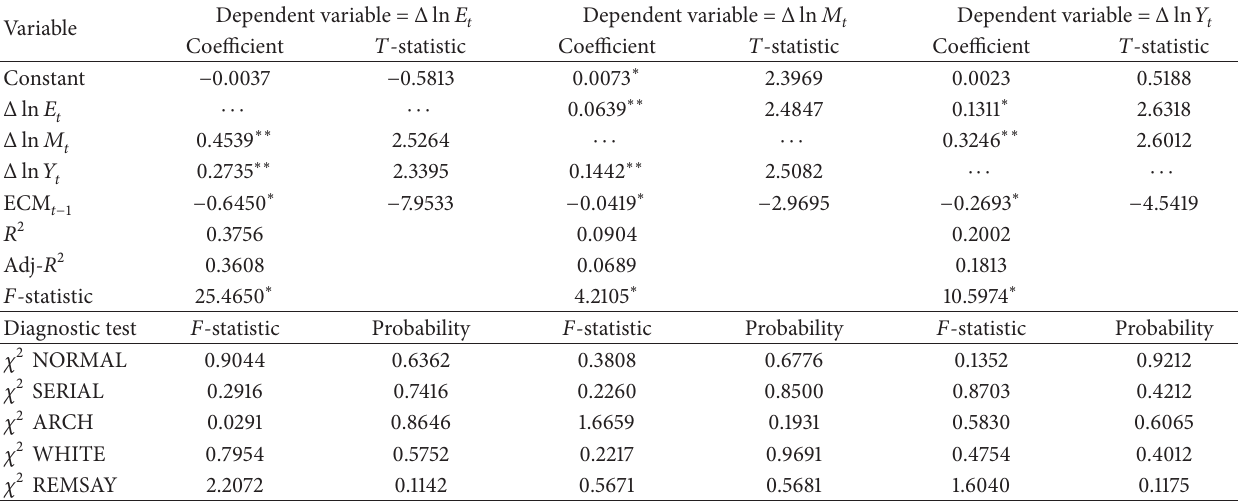
Table 7: Short run